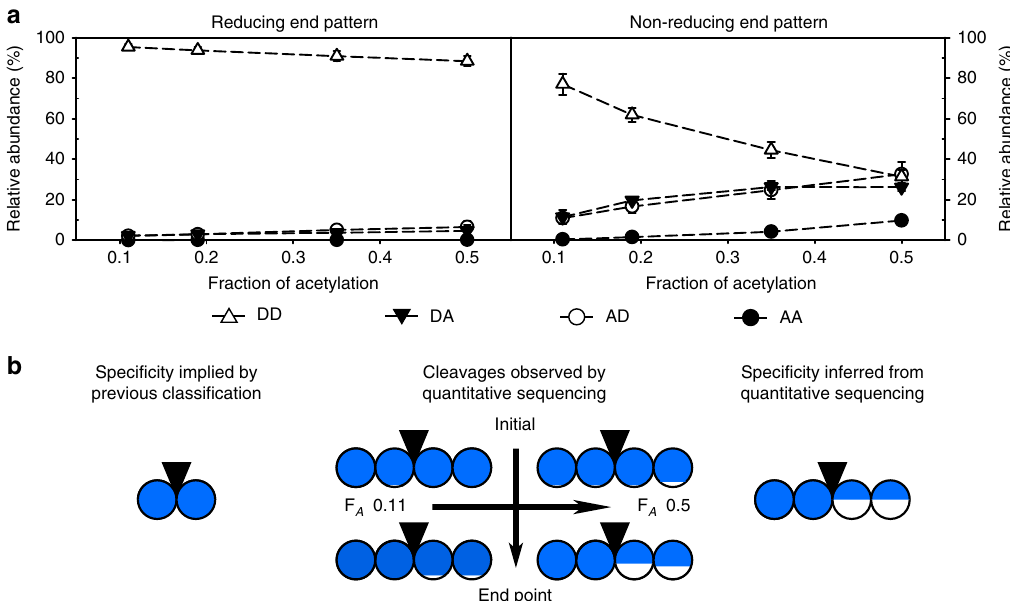
Fig. 4 Speci fi city of CSN-MN (being highly similar to CSN-7M representing class II) inferred from its products. ( a ) The patterns of acetylation of the two terminal sugar units were analyzed for different F A of the substrates by quantitative sequencing of the products at the endpoint of enzymatic hydrolysis. The molar fractions (mean values of at least three independent measurements of three independent enzyme batches) of all possible diads (DD, DA, AD, and AA) are shown. ( b ) The speci fi city of class II chitosanases implicated by the established qualitative classi fi cation system compared to the speci fi city of CSN-MN (97% similar to the model class II chitosanase CSN-7M) inferred from the cleavages observed by the quantitative sequencing of its products ’ sugar moieties. Diad frequencies at the early time points of enzymatic hydrolysis are taken from Supplementary Table 5. Detailed oligomer compositions are shown in Supplementary Table 3. The circles are divided according to the percentage of the relative abundances (molar fractions) of GlcN (blue) and GlcNAc (white) at the two corresponding subsites, left, ( − 2) and ( − 1), and right, (+1) and (+2), of the catalytic cleavage site (indicated by a black inverted triangle). The mean values with standard deviations of at least three independent measurements of three independent enzyme batches are